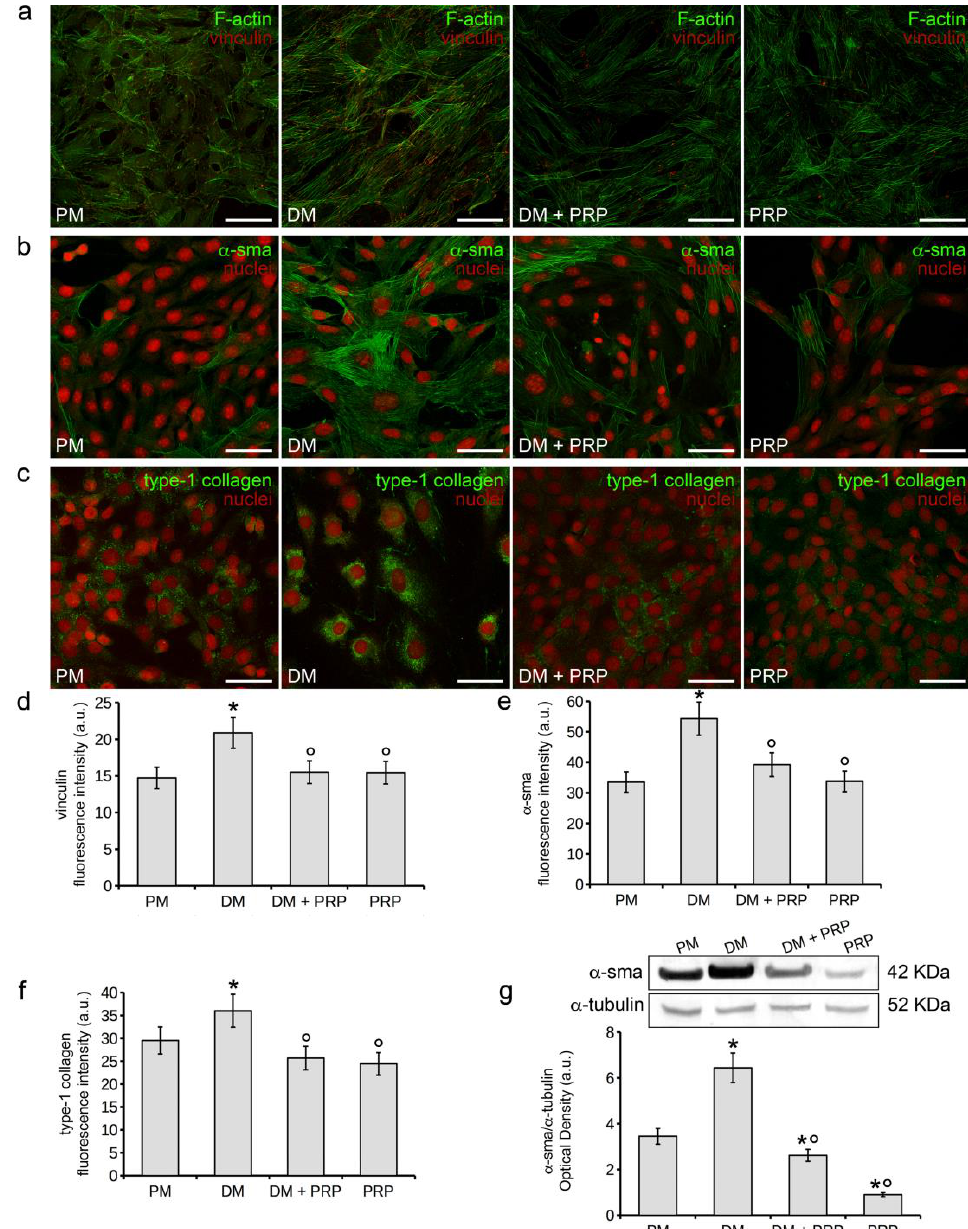
Figure 1. Evaluation of murine NIH/3T3 fibroblast to myofibroblast transition. The cells were induced to differentiate towards myofibroblasts by culturing for 48 h or 5 days in differentiation medium (DM, low serum medium plus 2 ng/mL TGF- β 1). Cells cultured in proliferation medium (PM) served as control, undifferentiated cells. To evaluate the effects of PRP on TGF- β1 -induced fibroblast-myofibroblast transition, cells were cultured in DM added with 1:50 diluted PRP (DM + PRP). In addition, the cells were cultured in the presence of 1:50 serum-free medium diluted PRP (PRP). ( a – c ) Representative confocal fluorescence images of the cells ( a ) stained with Alexa Fluor 488-conjugated phalloidin to reveal F-actin and immunostained with antibodies against vinculin, ( b ) immunostained with antibodies against α -sma or ( c ) type-1 collagen. In ( b , c ), nuclei are counterstained with propidium iodide. Scale bar: 50 µ m. ( d – f ) Histograms showing the densitometric analyses of the intensity of the fluorescence signals for each marker, performed on digitized images. ( g ) Western blotting analysis of α -sma expression. Histogram shows the densitometric analysis of the bands normalized to α -tubulin. Data shown are mean ± S.E.M. and represent the results of at least three independent experiments performed in triplicate. Significance of difference: * p < 0.05 vs. PM; ° p < 0.05 vs. DM.